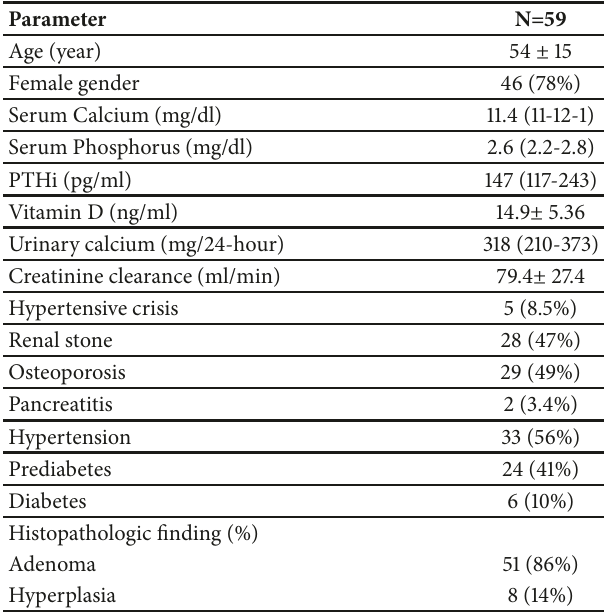
Table 1: Clinical biochemicaland pathology finding inpatients with severe primary